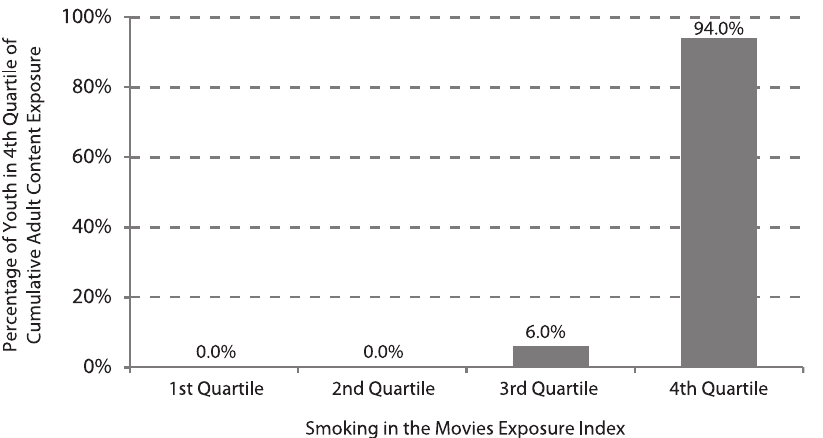
Figure 1. Percentage of the New York Longitudinal Youth Tobacco Evaluation Survey (NY-LYTES) 2005–2008 Sample in the Highest Quartile of Exposure to Adult Content in Movies for each Quartile of Exposure to Smoking in